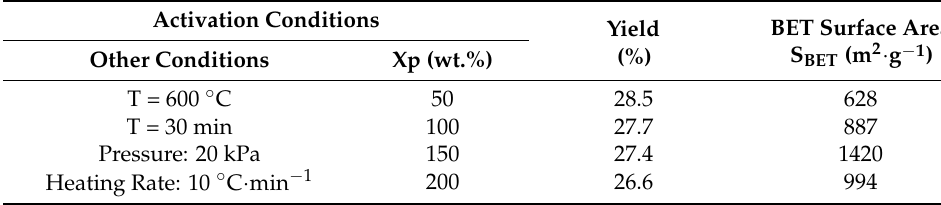
Table 4. Activation conditions, yield, and BET surface area of activated